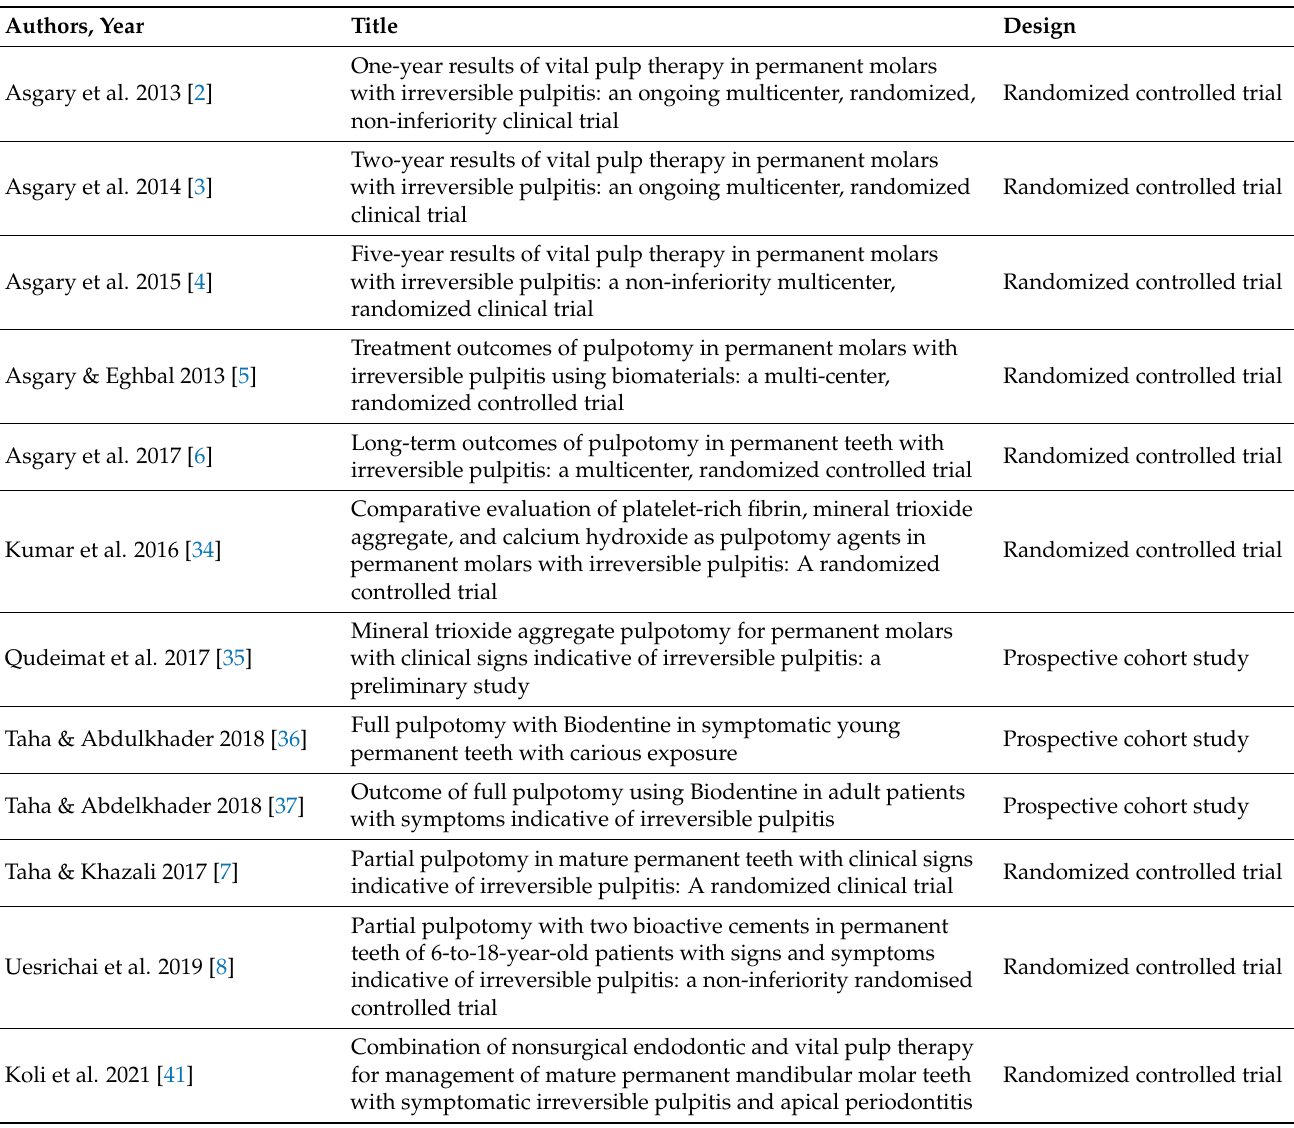
Table 2. Articles included in this systematic